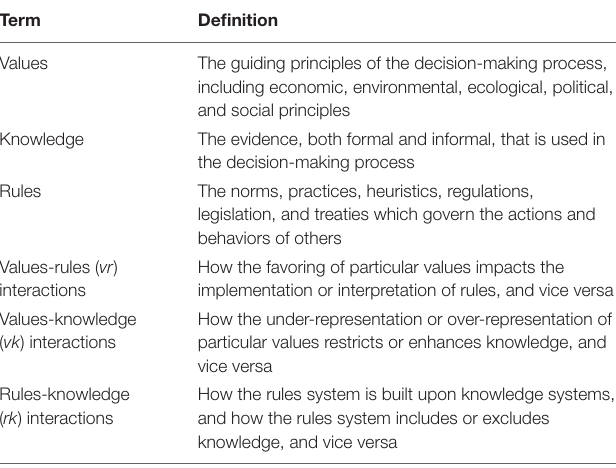
TABLE 2 | A summary of the key terms used in the vrk framework (Gorddard et al.,